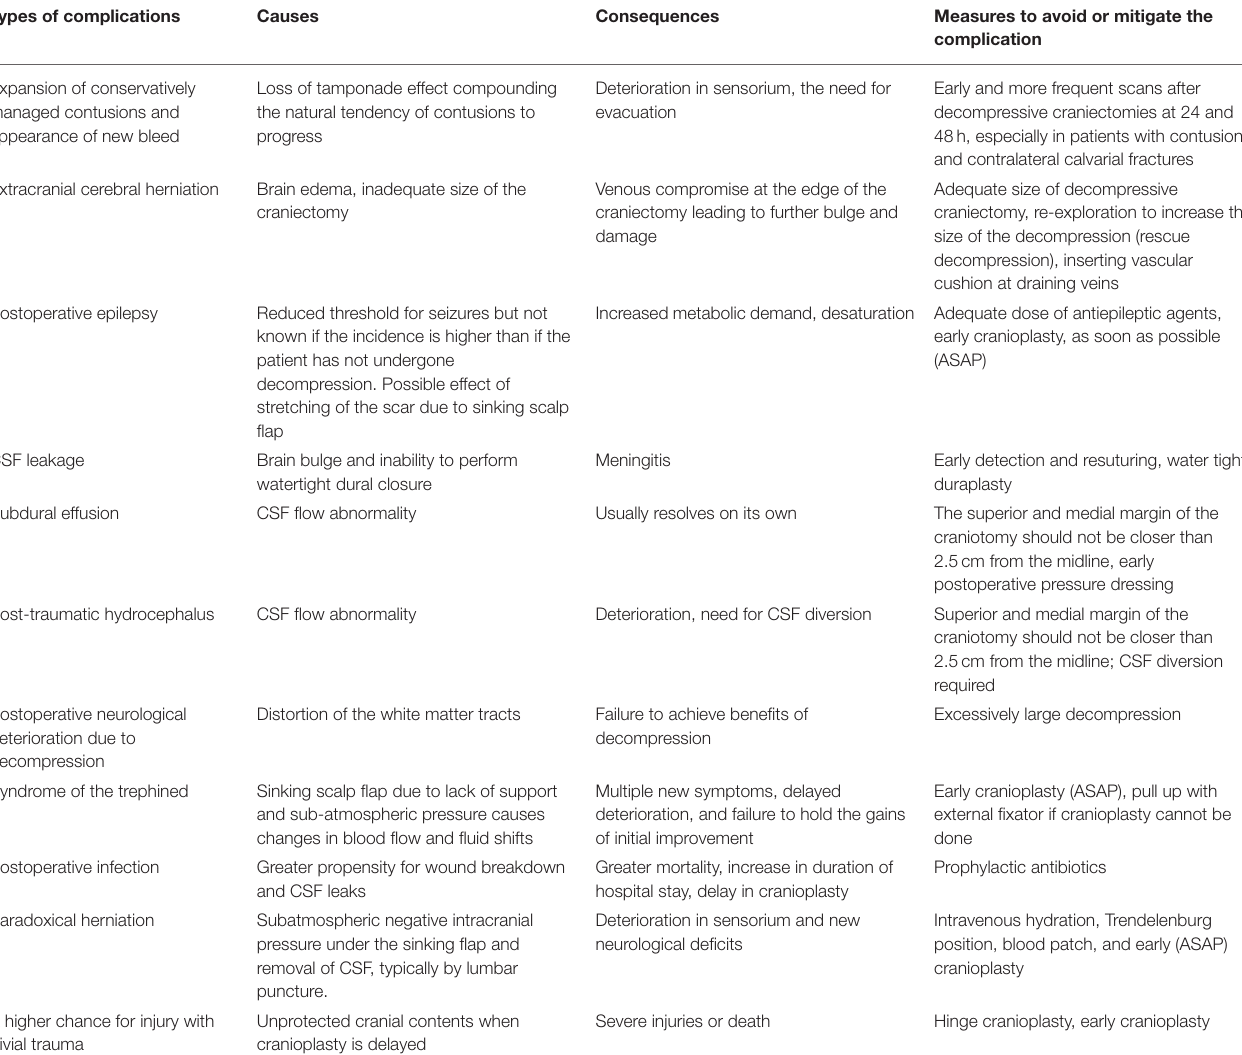
TABLE 2 | Types, causes, consequences, and measures to avoid or treat